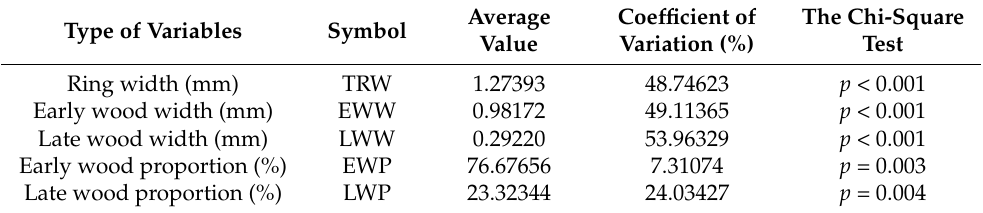
Table 3. Descriptive statistics of the configuration of annual rings in the studied samples.